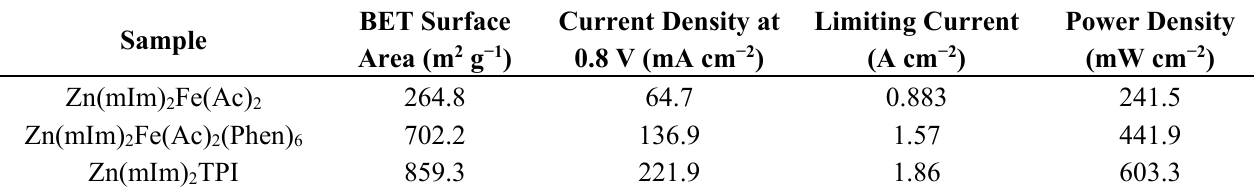
Table 1. Brunauer-Emmett-Teller (BET) Surface area and Activity with Different Iron Additives. BET surface area reported on autoclaved samples before any further processing was performed. Fuel cell data is reported for all three samples, including current density at 0.8 V iR-free , limiting current, and maximum power density. Fuel cell conditions: 1 bar P P = = (back pressure = 7.3 psig) fully humidified; T = 80 °C; N211 membrane; 2 2 O H 5 cm 2 membrane-electrode assemblies (MEA); cathode catalyst = 3.5–4 mg/cm 2 , anode catalyst = 0.4 mg Pt /cm 2